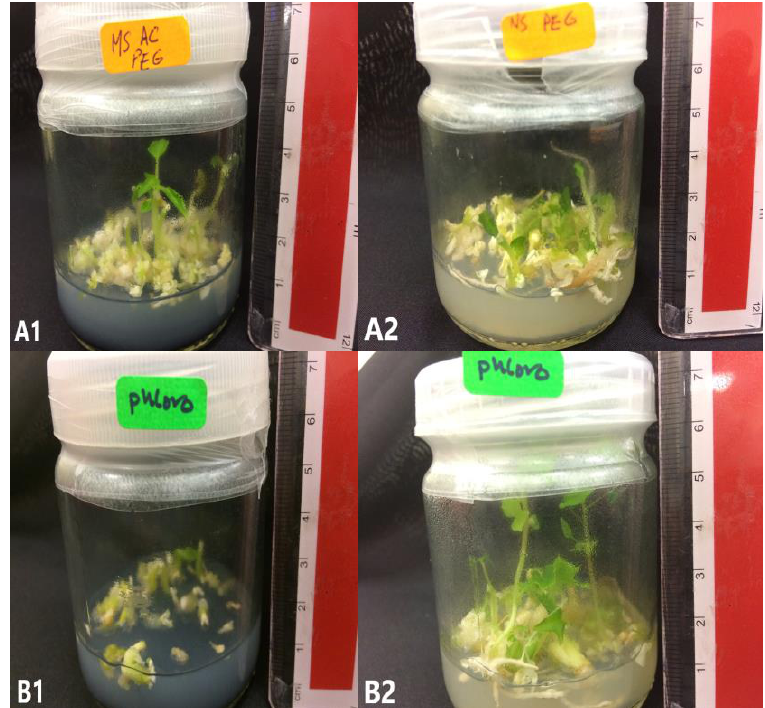
Figure 7. C. papaya “Eksotika” in germination media A1, explant germinated in G1 media. A2, explant germinated in G2 media. B1, explant germinated in G3 media. B2, explant germinated in G4 media.